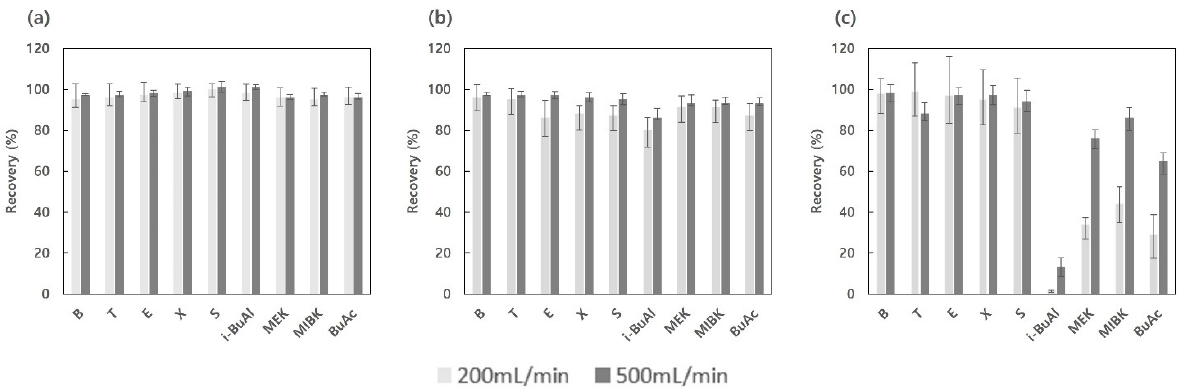
Figure 6. Comparison of VOC recovery rates according to various moisture pretreatment devices: ( a ) KPASS–Odor; ( b ) Cooler; ( c ) Nafion TM dryer. ( a ) KPASS–Odor; ( b ) Cooler; ( c ) Nafion TM At a flow rate of 200 mL/min, the recovery rate of KPASS–Odor was >95% for all compounds. At a flow rate of 500 mL/min, the recovery rate was >96% for all components. The recovery rate of the cooler was 96% for benzene and 95% for toluene. For the other components, the recovery rates were determined to be 91%, 91%, 88%, 87%, 87%, 86%, and 80% for MEK, MIBK, p-xylene, styrene, BuAc, ethyl benzene, and I-BuAl. The recov-